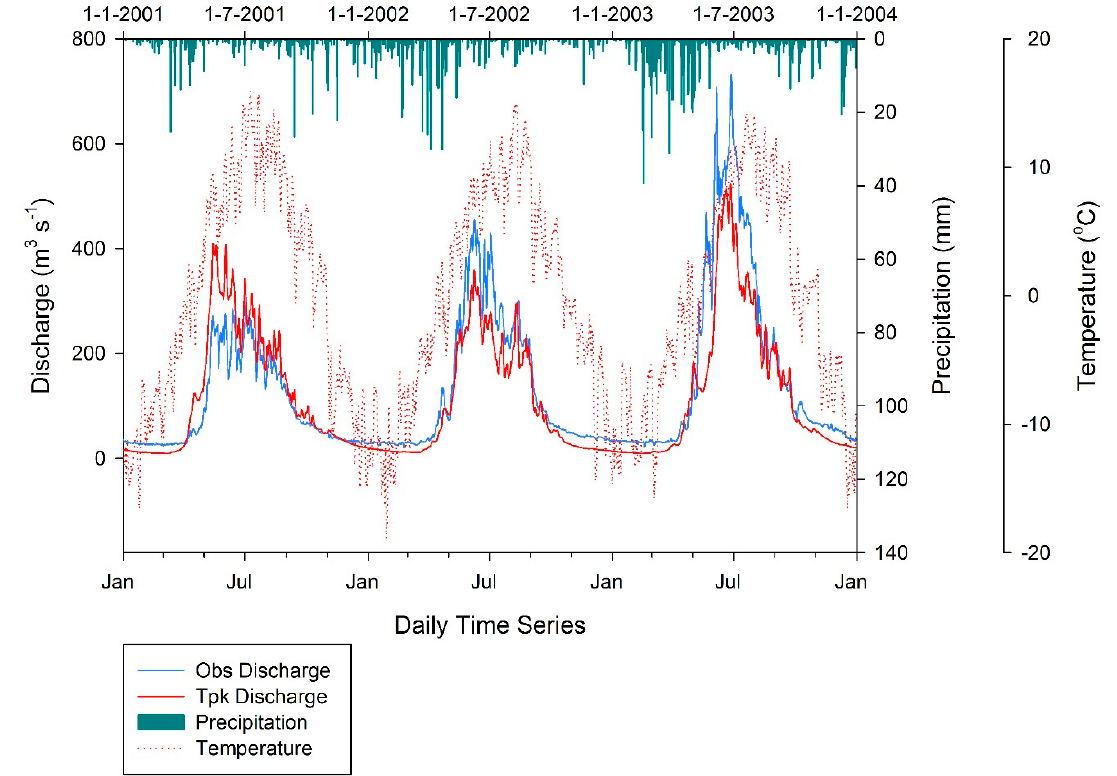
*indicate significance at α = 0.05 and d is the Index of Agreement [76].